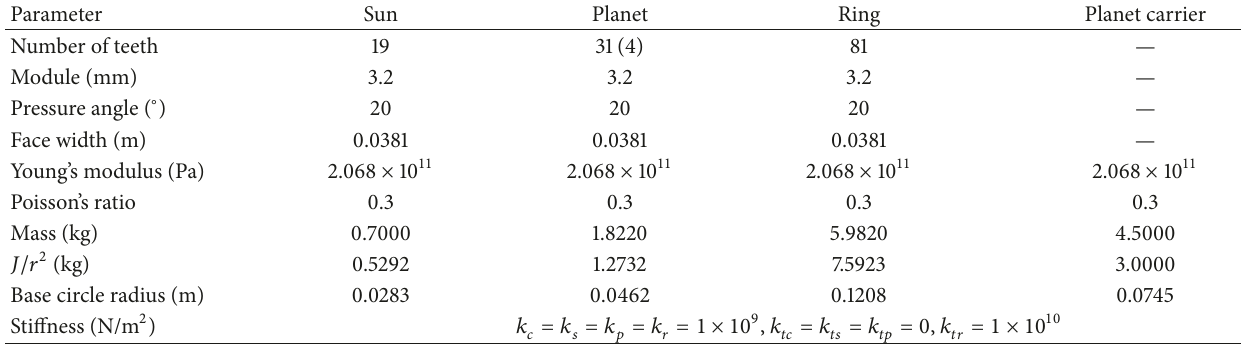
Table 1: Planetary gear set